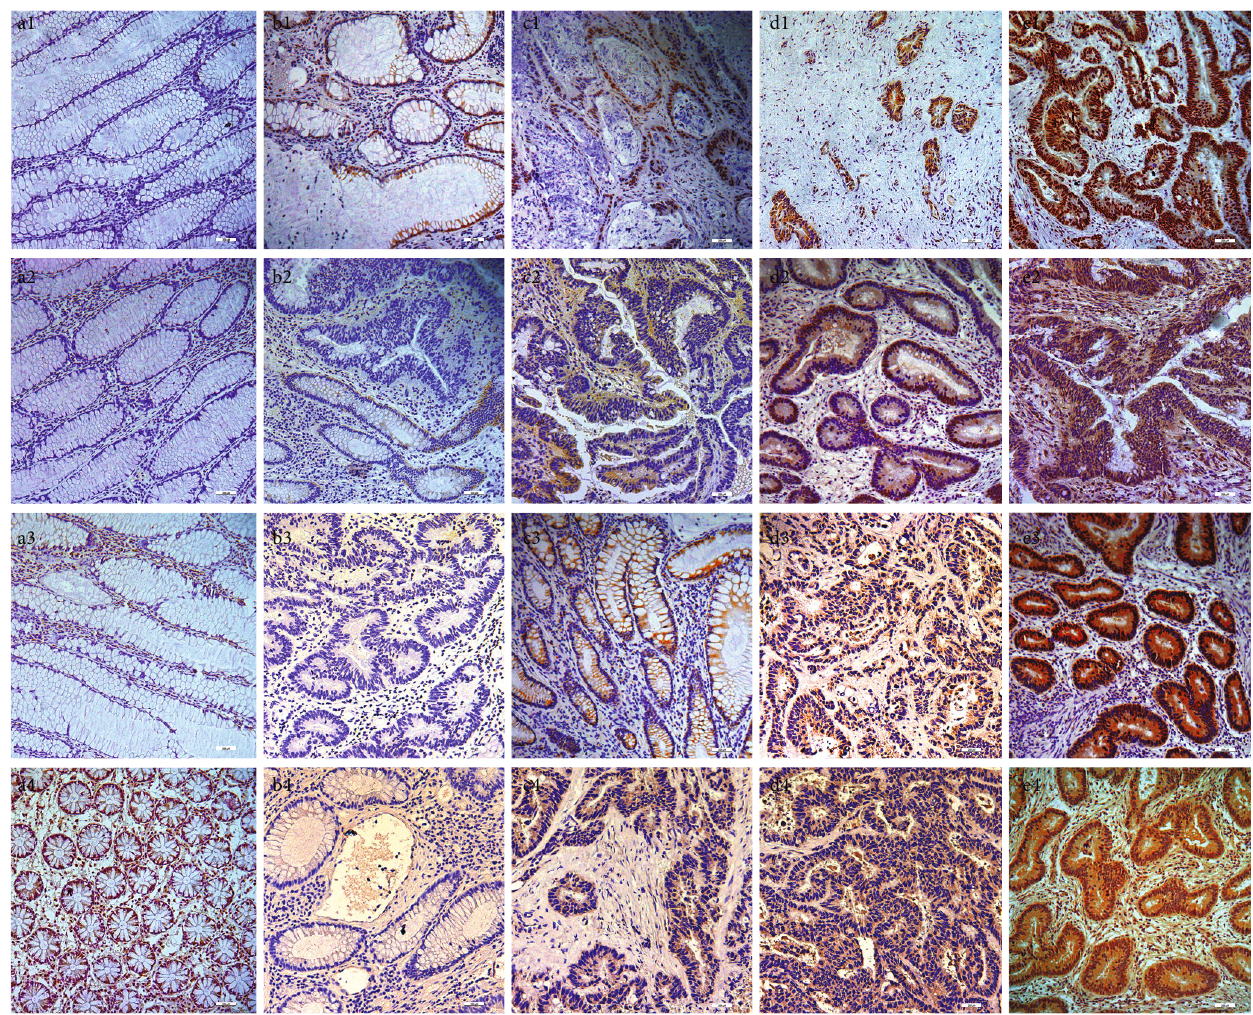
Figure 1: Representative images showing AKAP95, B-Raf, ERK1/2, and ELK-1 expressions in colon cancer and para-carcinoma tissue (magni fi cation=10 × ). (a1) No AKAP95 expression in para-carcinoma tissue. (b1) AKAP95 showing some expression ( − or ± ) in colon cancer tissue. (c1) Lowly expressed AKAP95 (+) in colon cancer tissue. (d1) Moderately expressed AKAP95 (++) in colon cancer tissue. (e1) Highly expressed AKAP95 (+++) in colon cancer tissue. (d1) and (e1) AKAP95 expression not only in the nuclei, but also in the cytoplasm. (a2) No B-Raf expression in para-carcinoma tissue. (b2) B-Raf showing some expression ( − or ± ) in colon cancer tissue. (c2) Lowly expressed B-Raf (+) in colon cancer tissue. (d2) Moderately expressed B-Raf (++) in colon cancer tissue. (e2) Highly expressed B- Raf (+++) in colon cancer tissue. (c2) – (e2) B-Raf expression in the cytoplasm. (a3) No ERK1/2 expression in para-carcinoma tissue. (b3) ERK1/2 showing some expression ( − or ± ) in colon cancer tissue. (c3) Lowly expressed ERK1/2 (+) in colon cancer tissue. (d3) Moderately expressed ERK1/2 (++) in colon cancer tissue. (e3) Highly expressed ERK1/2 (+++) in colon cancer tissue. (c3) ERK1/2 mainly expression in the cytoplasm. (d3) and (e3) ERK1/2 expression in the cytoplasm and nucleus. (a4) No ELK-1 expression in para- carcinoma tissue. (b4) ELK-1 showing some expression ( − or ± ) in colon cancer tissue. (c4) Lowly expressed ELK-1 (+) in colon cancer tissue. (d4) Moderately expressed ELK-1 (++) in colon cancer tissue. (e4) Highly expressed ELK-1 (+++) in colon cancer tissue. (c4) and (d4) ELK mainly expression in the cytoplasm. (e4) ELK-1 expression in the cytoplasm and